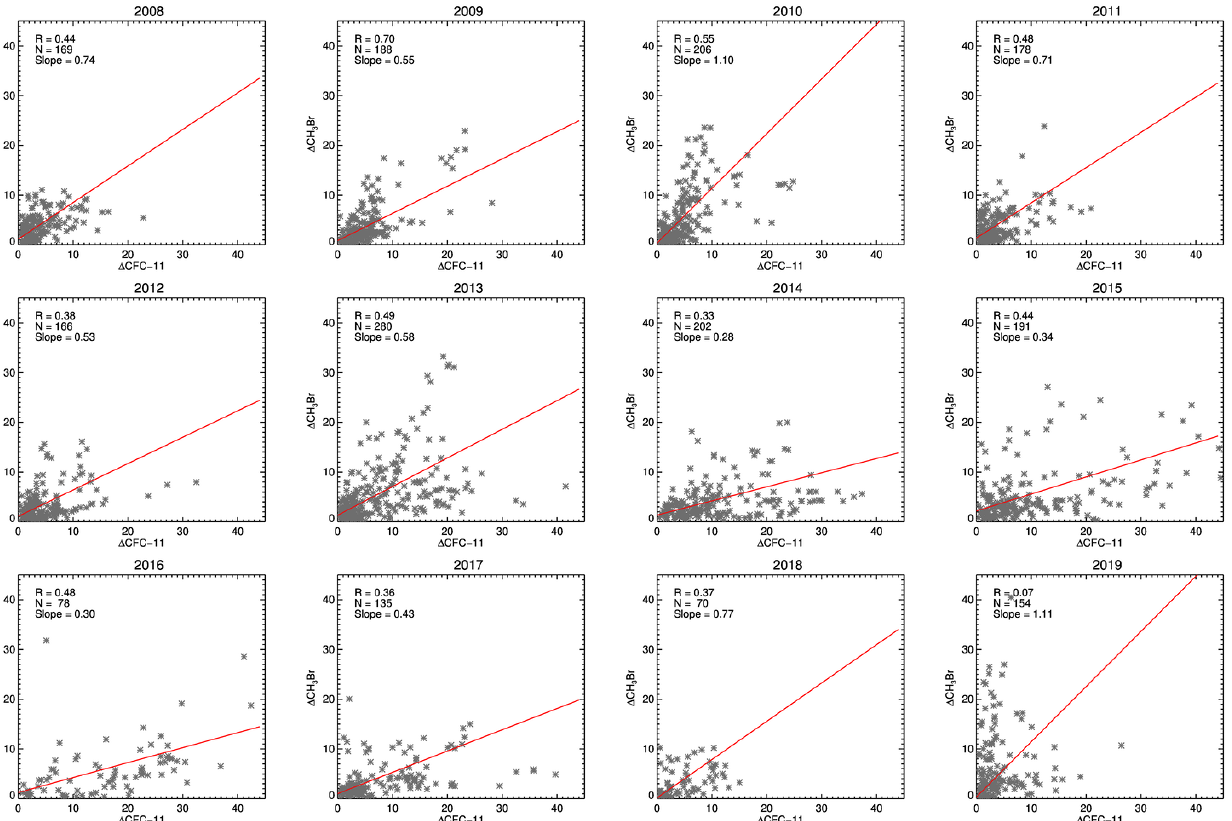
Figure 7. The annual correlation between the enhancement of CH 3 Br and CFC-11 above the baseline measured at Gosan from 2008 to 2019. The linear trend line was derived by the weighted Deming regression